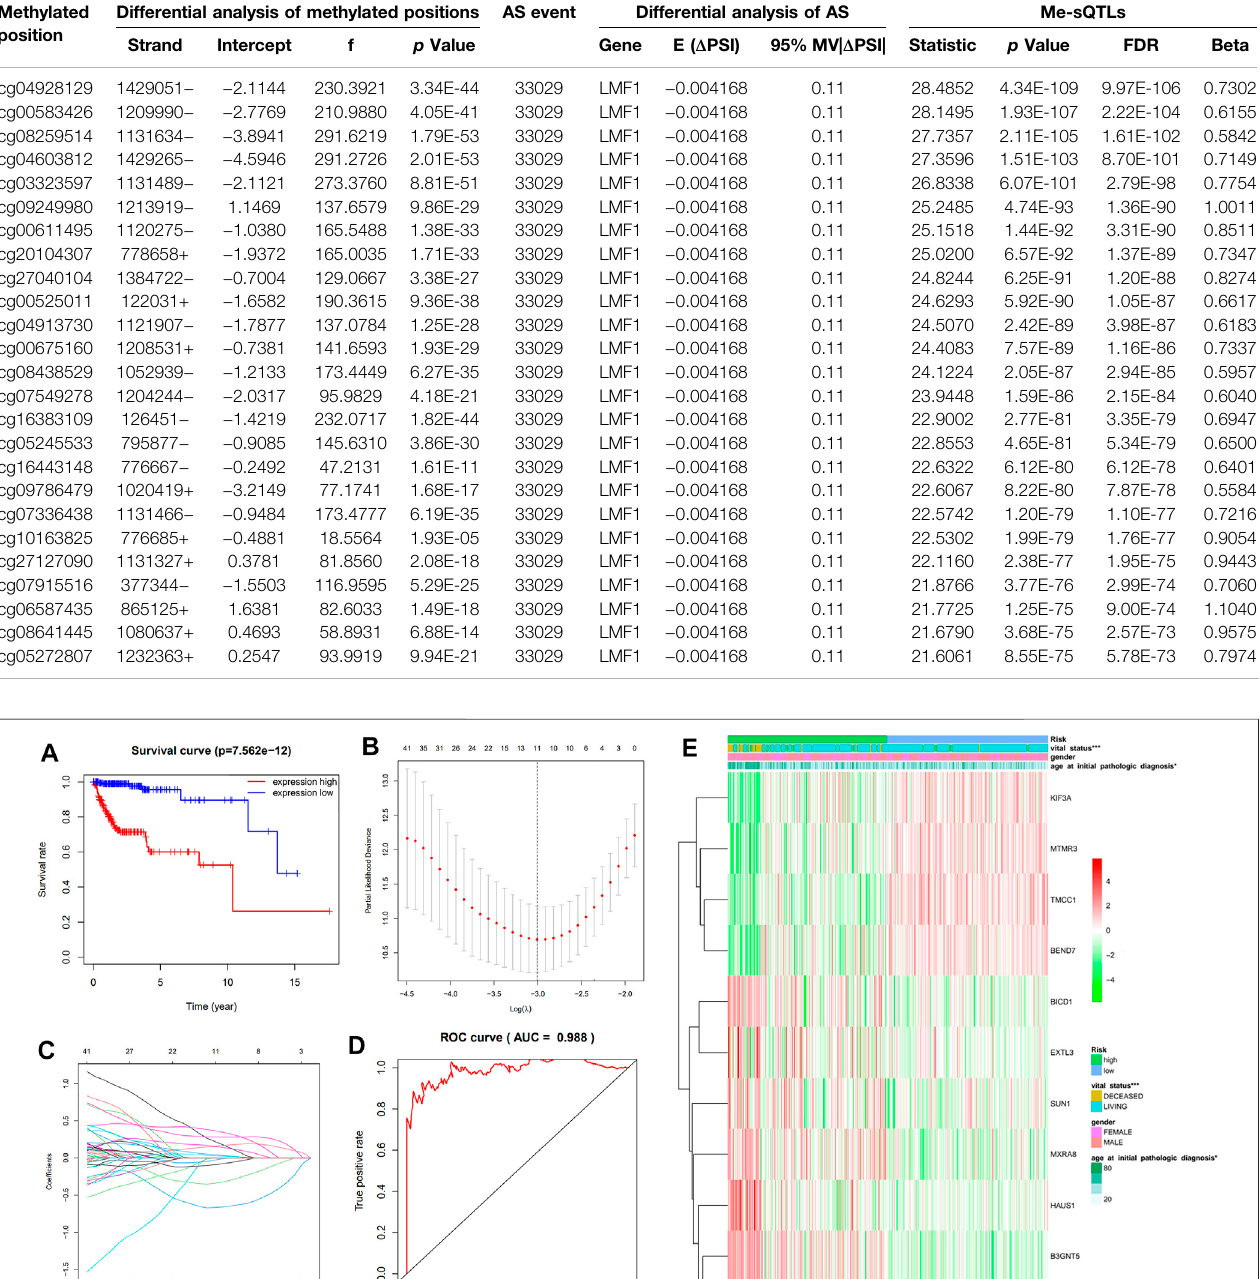
TABLE 2 | The top 25 signi fi cant results of the me-sQTLs and the differential AS events affected by the methylated position. Methylated Differential analysis of methylated positions AS event position